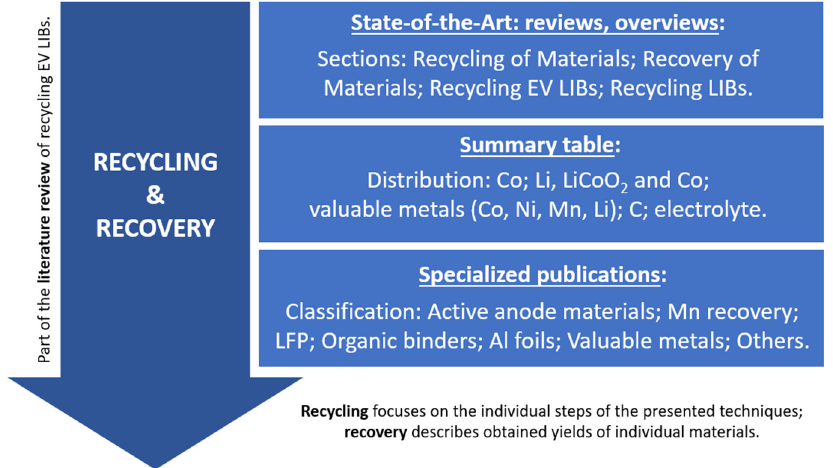
Figure 4. Methodology of Recycling Processes and Recovery Efficiencies